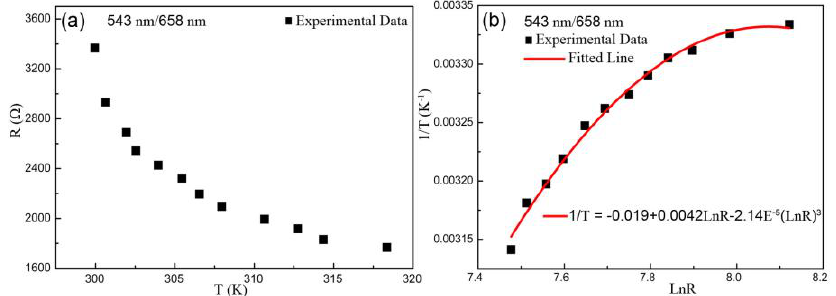
Figure 5. Plots of the ratio of 543 nm/658 nm including ( a ) the resistance – temperature experimental data, and ( b ) the fitted curve of resistance dependent temperature based on Steinhart–Hart formula.